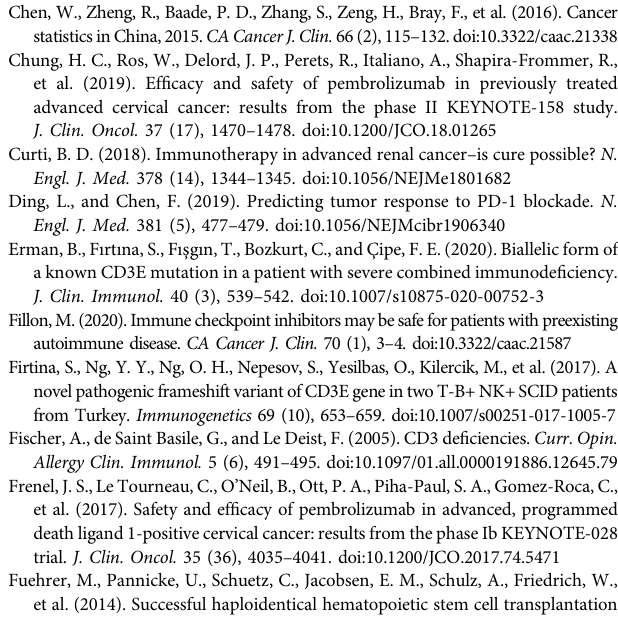
Supplementary Figure 2 | Sample dendrogram and trait heatmap. Each branch in the image represents one CESC patient and gray below represents missing data. Supplementary Figure 3 | Analysis of the scale-free fi t index for multifarious soft- thresholding powers ( β ). Supplementary Figure 4 |LASSOplot of hub IRGs ofthe prognostic signature. (A) The best lambda was selected at the lowest point of the curve (minimal partial likelihood deviance). LASSO compresses the coef fi cients of some covariates to 0, leaving thirteen non-zero coef fi cients. (B) Penalty graph of characteristic thirteen variable coef fi cients. Three variables (CD3D, CD3E, LCK) with non-zero coef fi cients were identi fi ed at the best lambda, and the feature parameters without information are removed to realize the automatic selection of feature parameters. Supplementary Figure 5 | The correlation of CD3D, CD3E, LCK expression with tumor purity and immune in fi ltrating cells. Supplementary Figure 6 | The correlation of prognostic signature and ESTIMATA ESTIMATE score. Supplementary Figure 7 | TIDE value of CESC patients to predict the immunotherapy sensitivity. Responder represents positive immunotherapy sensitivity while non-responder represents negative immunotherapy sensitivity. TIDE, Tumor Immune Dysfunction and Exclusion; CESC, cervical squamous cell carcinoma. Supplementary Table 1 | The clinical/pathological factors between Estimate high score group and low score group. Supplementary Table 2 | The in fi ltrating immune cells with the given prognostic signature. Supplementary Table 3 | The immune functions with the given prognostic